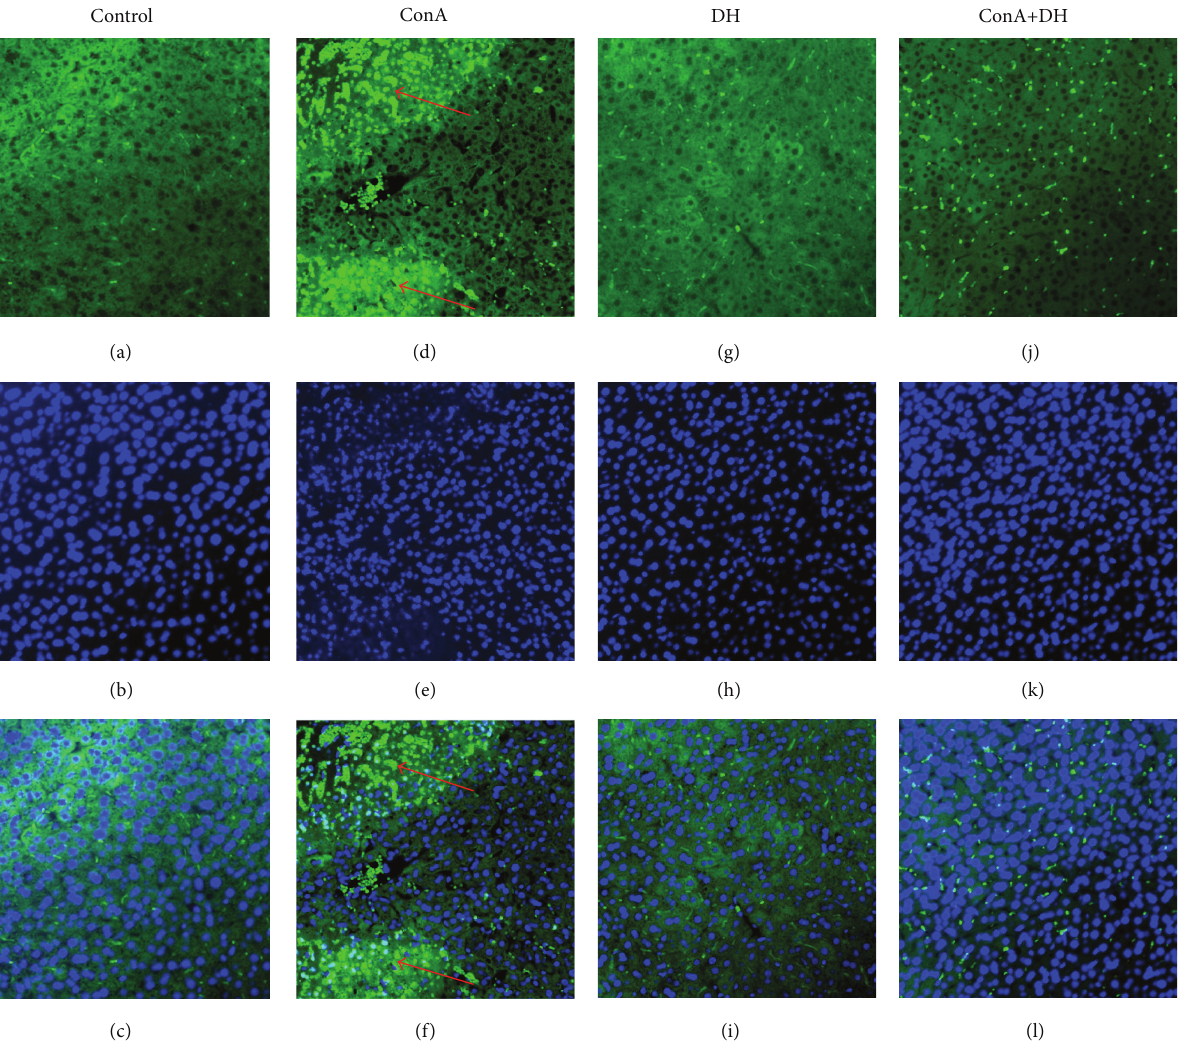
Figure 4: DH inhibits ConA-induced hepatic apoptosis. Notes: mice were sacrificed at 24 hours after ConA injection. The livers were harvested from Control , ConA , DH, and ConA+DH groups, respectively. Images showing TUNEL-labeled (green) apoptotic cells counterstained with DAPI (blue) in liver tissue sections. DAPI-stained sections (b, e, h, and k) label the nuclei, while TUNEL-labeling (a, d, g, and j) reveals apoptotic cells. Colocalization of TUNEL/ DAPI (c, f, i, and l) in liver sections. The arrows indicate an aggregate of apoptotic cells in liver section (d and f) of ConA injection group. Original magnification × 200. ConA: Concanavalin A; DH: Dracocephalum heterophyllum ; TUNEL, terminal deoxynucleotidyl transferase- (TdT-) mediated dUTP-biotin nick end labeling; DAPI: 4 󸀠